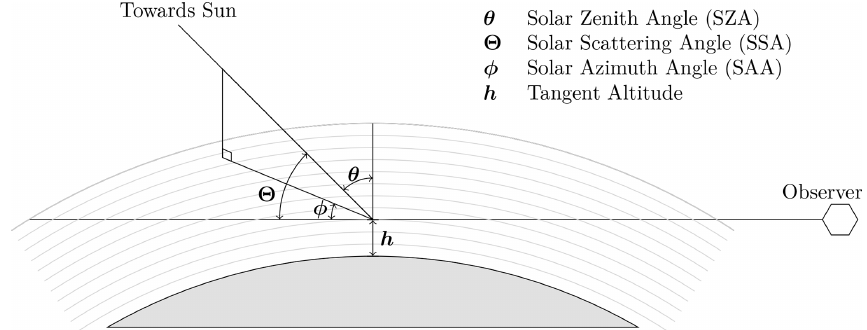
Figure 1. The limb-viewing geometry and definitions of solar zenith angle, solar azimuth angle, solar scattering angle, and tangent altitude. The tangent altitude and solar zenith angles are defined relative to the un-refracted tangent point such that a solar scattering angle of 0 ◦ is perfect forward scatter, and a solar zenith angle of 0 ◦ is the sun directly overhead. Figure adapted from Zawada et al.